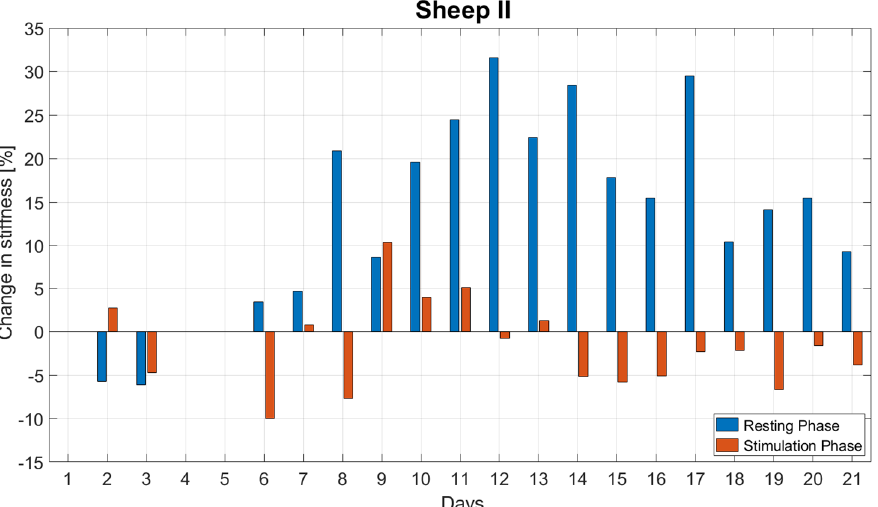
Figure 7. Daily changes in stiffness during the resting and stimulation phases for the first three weeks post-op for Sheep II. The stiffness change during resting was significantly larger than during stimulation ( p < 0.001).